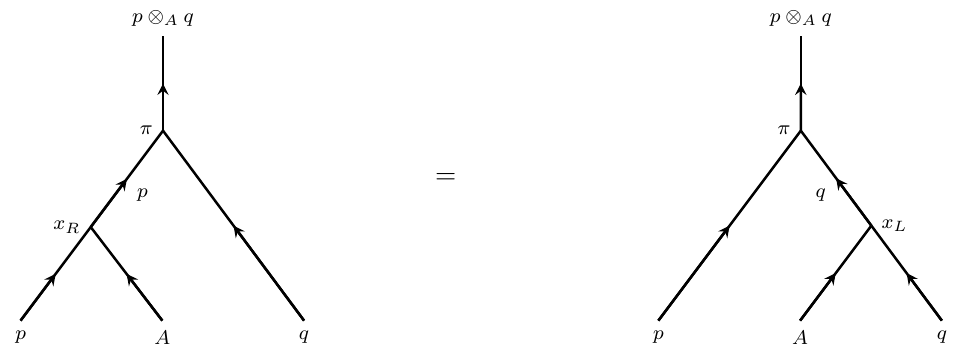
Figure 17 . De(cid:12)nition of ( A; A )-bimodule ( p; x L ; x R ).